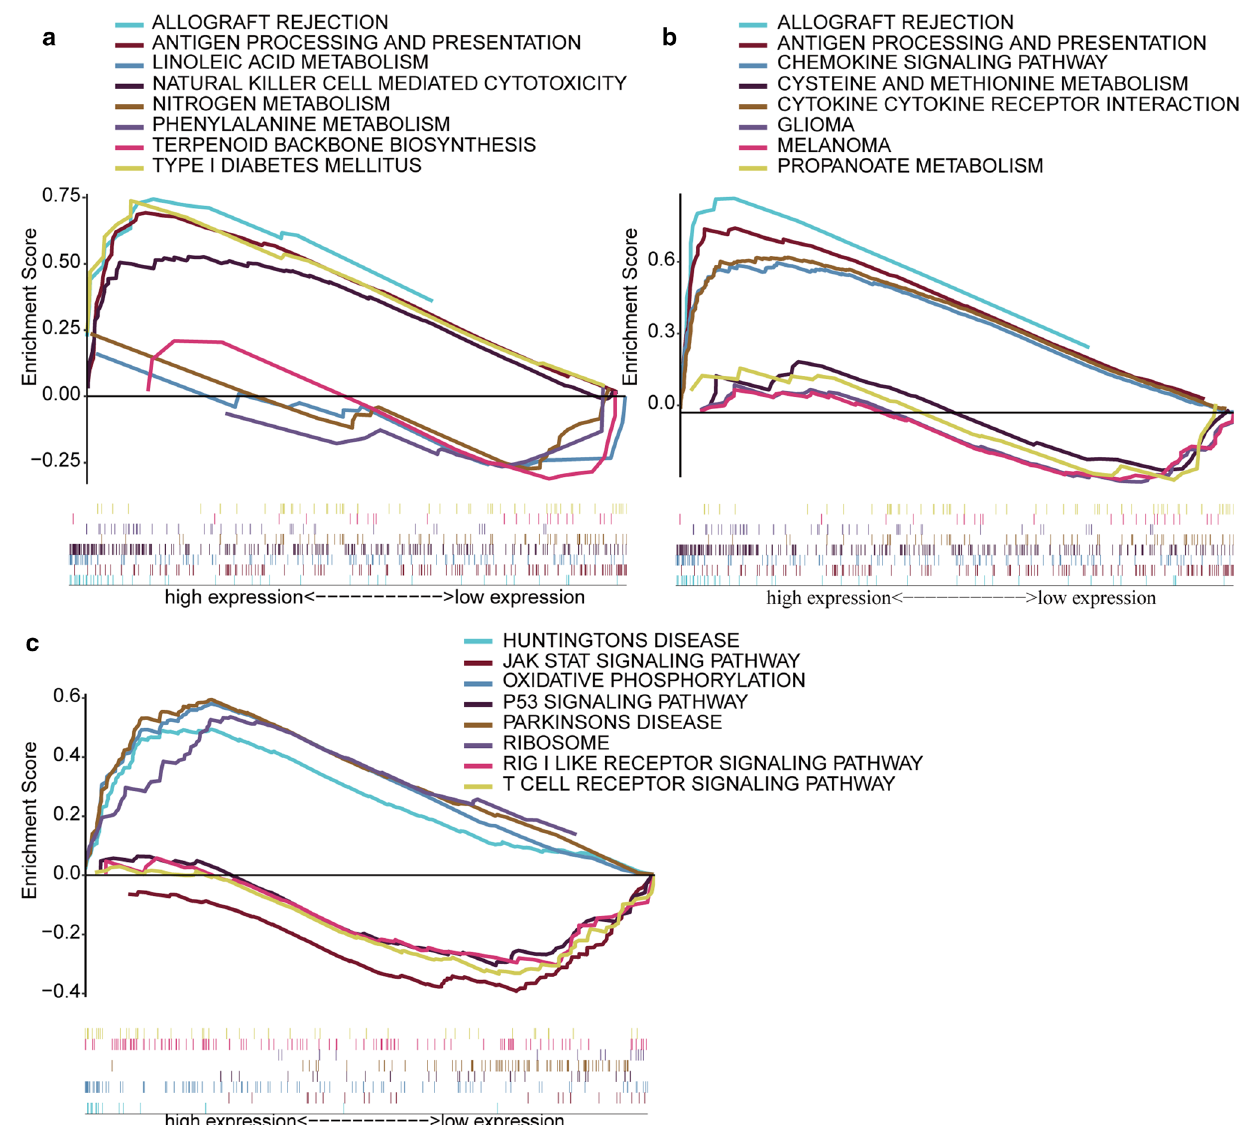
Fig. 9 Enrichment plots from gene set enrichment analysis of key prognostic genes. a Signaling pathways of CD86. b Signaling pathways of LCP2. c Signaling pathways of SLA. KEGG analysis showed five signal pathways in high and low gene expression groups, respectively. Each line represented a specific gene set with unique color. The left leaning curves (positive enrichment scores) demonstrated the pathway enriched in high expression group, while the right leaning curves (negative enrichment scores) demonstrated the pathway enriched in low expression group